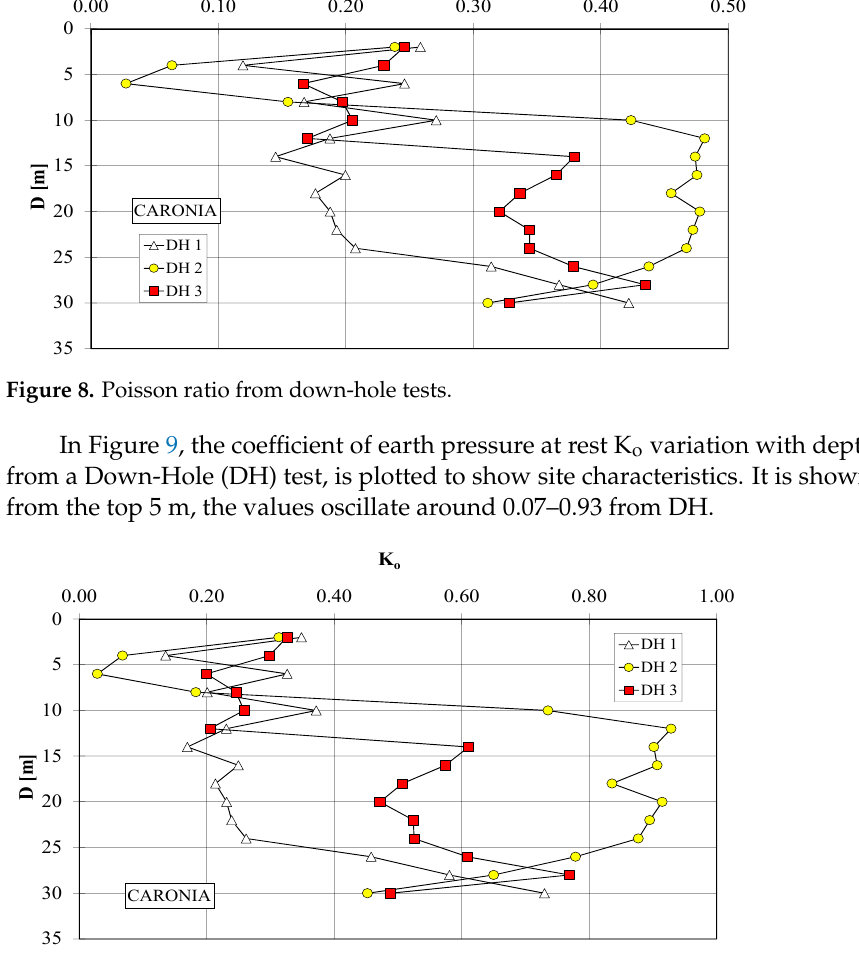
Figure 9. The coefficient of earth pressure at rest K 0 from down-hole tests.